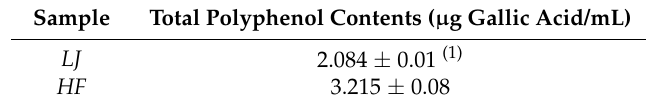
Table 1. Total polyphenol contents of Laminaria japonica ( LJ ) and Hizikia fusiforme ( HF ) extracts.